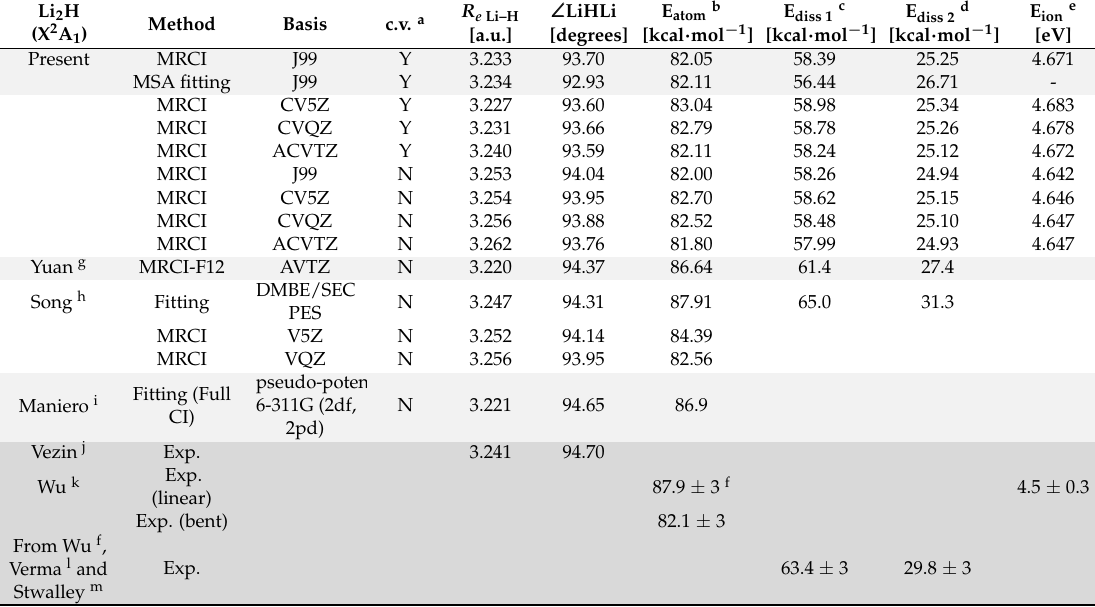
Table 1. Comparison of equilibrium geometries and energies of the ground electronic state X 2 A 1 of Li 2